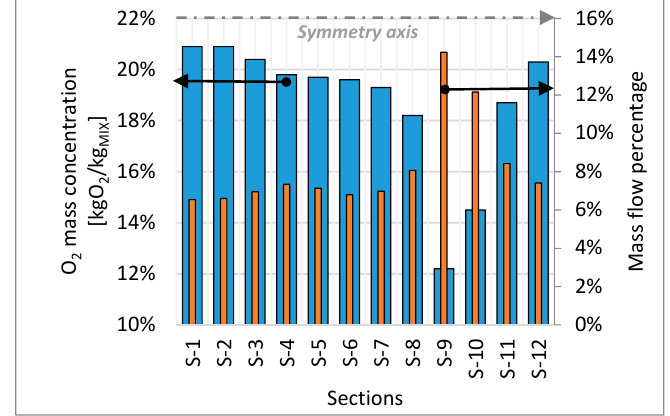
Figure 10. Oxygen mass fraction profile in the Cold phase chamber stacking (20% average waste gas fraction) [20].